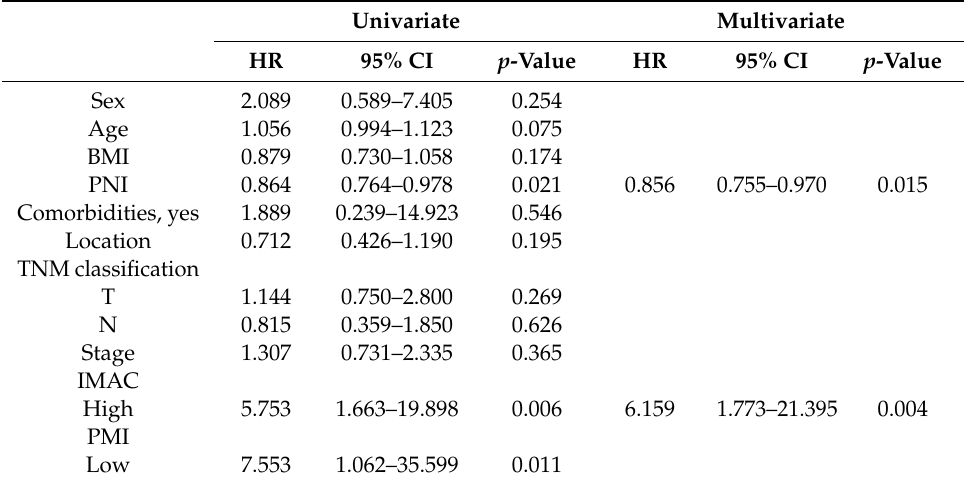
Table 2. Univariate and multivariate analyses using the Cox proportional hazards regression model. Univariate